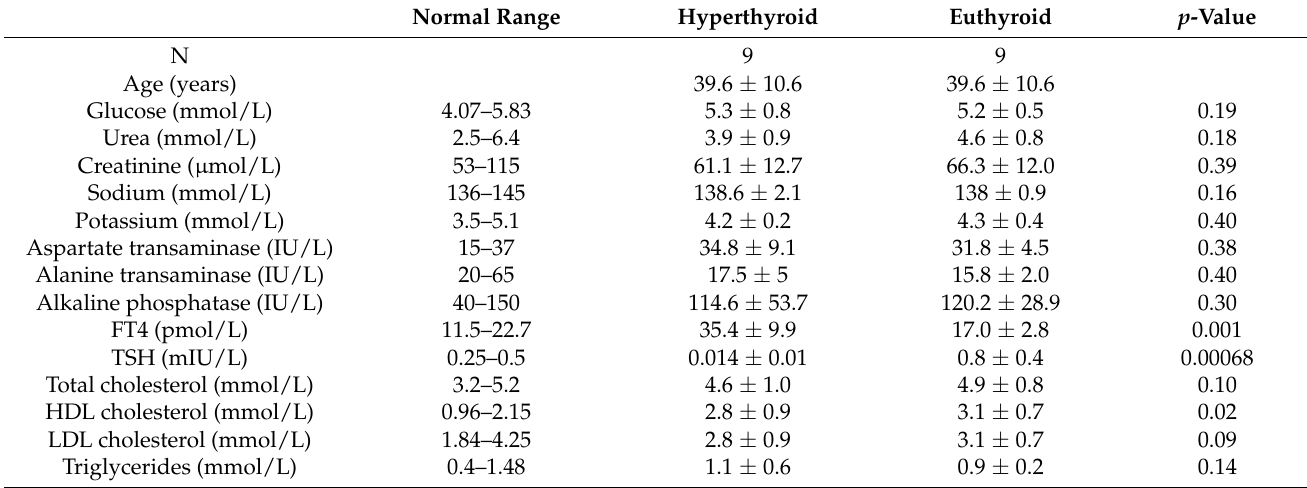
Table 1. Biochemical parameters of the hyperthyroid study subjects before and after carbimazole therapy. FT4, free thyroxine; TSH, thyroid-stimulating hormone; HDL, high-density lipoprotein; LDL, low-density lipoprotein. Normal